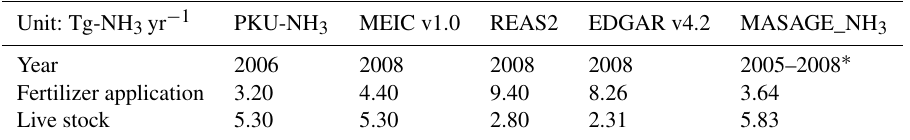
Figure 15. Comparisons of spatial distribution of NH 3 agricultural emissions between MEIC v1.0 and PKU-NH 3 . Provinces that included in tropical zones are Fujian, Guangdong, Hainan, Guangxi, Guizhou, Hubei, Hunan, Yunnan, Sichuan, Jiangxi, Anhui, Zhejiang, and Jiangsu. Other provinces are treated as temperate ones. Table 8. NH 3 agriculture emission estimates for